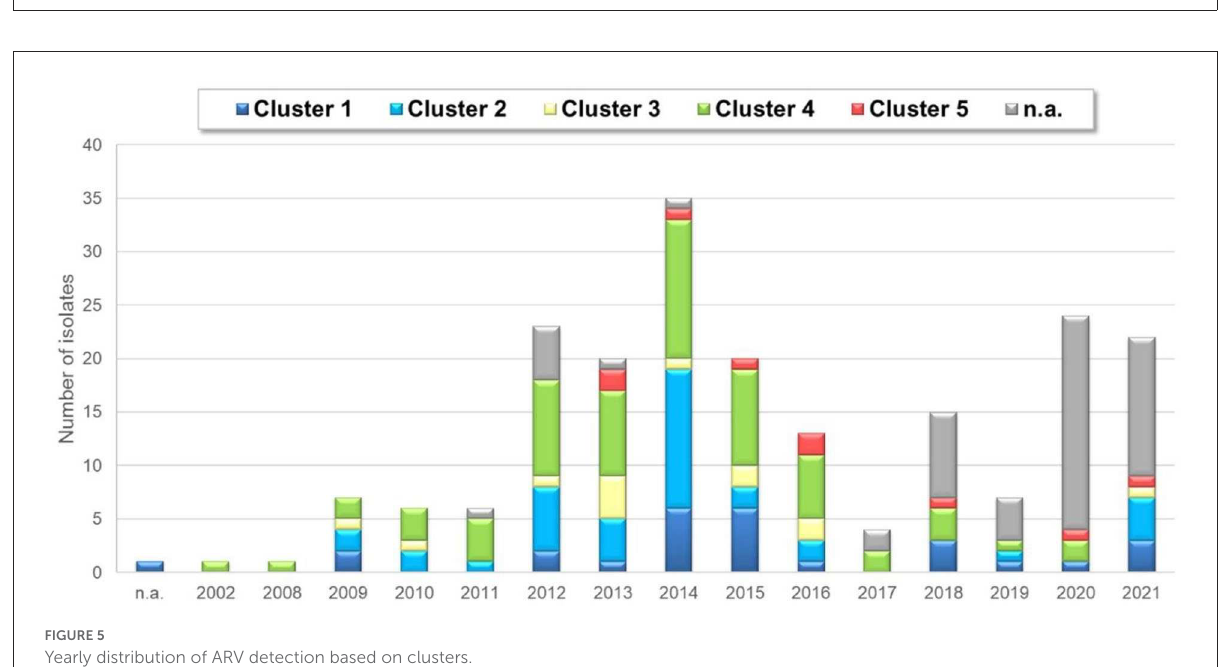
FIGURE5 Yearly distribution of ARV detection based on